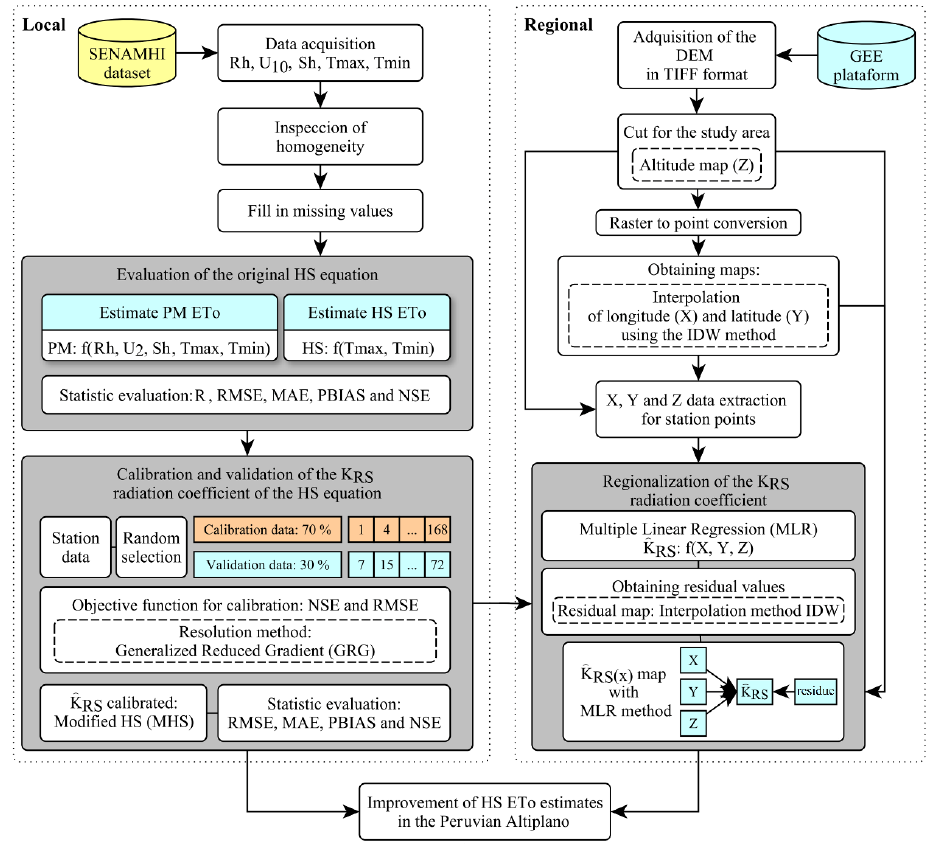
Figure 3. Flow diagram for the improvement of the Hargreaves–Samani reference evapotranspiration estimates in the PA.